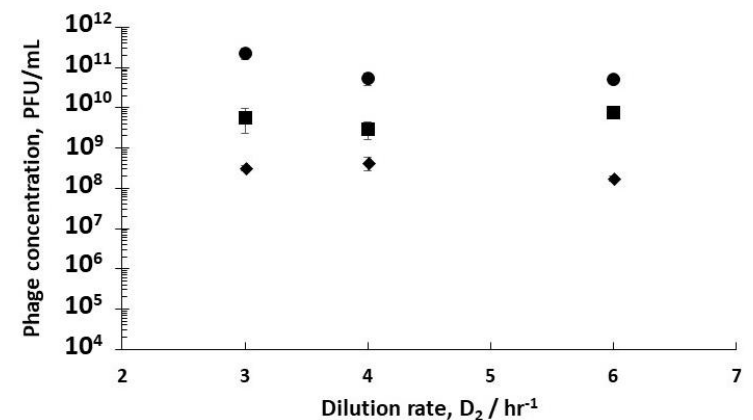
Figure 5. Final phage titres in Reactor 3 (R3) after overnight amplification following infection in R2 using dilution rates (D 2 ). Filled squares ( ■ ) correspond to phages infected in R2 when R1 was operated at D 1 = 0.4 hr −1 ; filled round circles (●) correspond to phages infected in R2 when R1 was operated at D 1 = 0.5 hr −1 ; filled diamonds ( ) correspond to phages infected in R2 when R1 was operated at D 1 = 0.6 hr −1 . Error bars represent one standard deviation.